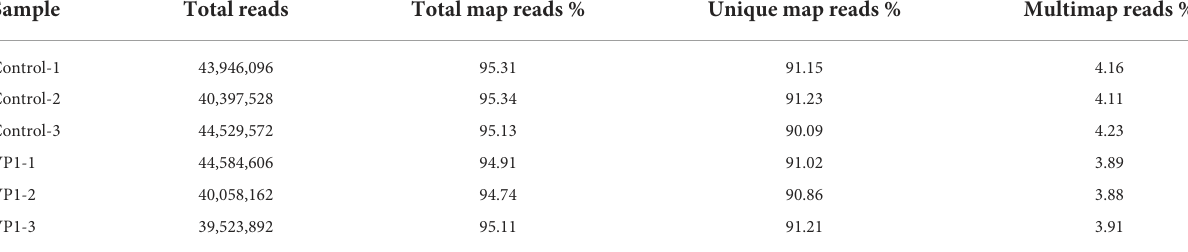
TABLE 3 Alignment